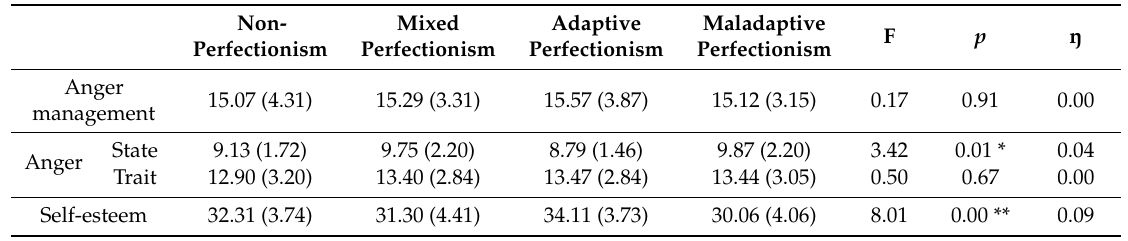
Table 4. Analysis of variance (ANOVA) according to perfectionist profiles (Gaudreau and Thompson,